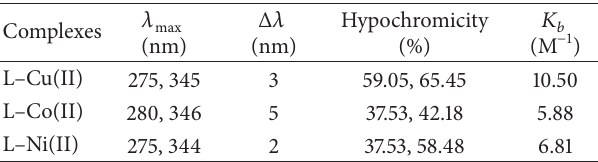
Table 5: Absorption properties of metal (II) complexes with CT-